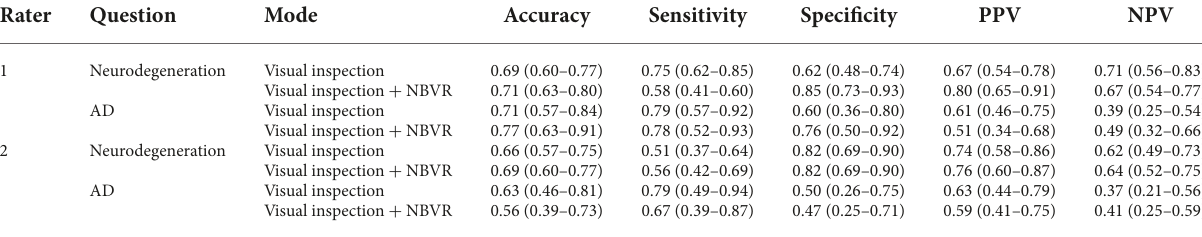
TABLE 1 Metrics of diagnostic accuracy including 95% confidence intervals for raters 1 and 2.